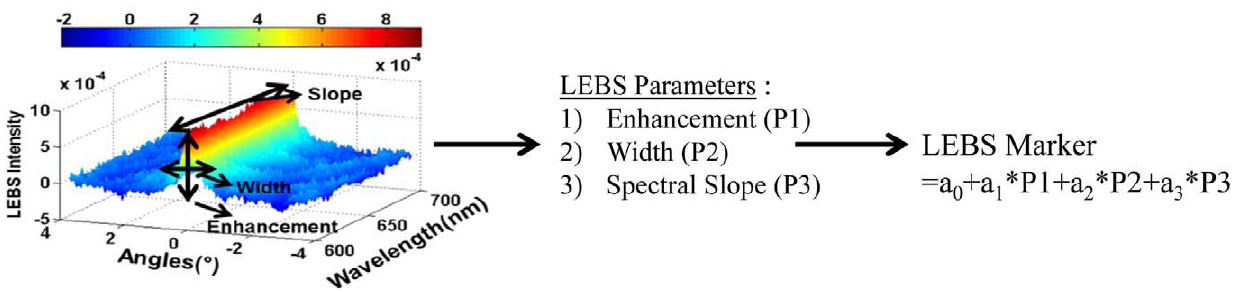
Fig. 1. Representative image of LEBS peak from intact rat tissue. LEBS images show the different parameters (E, W & S) calculated from this peak and the scheme for calculation of LEBS marker using logistic regression of LEBS parameters by linear combination.